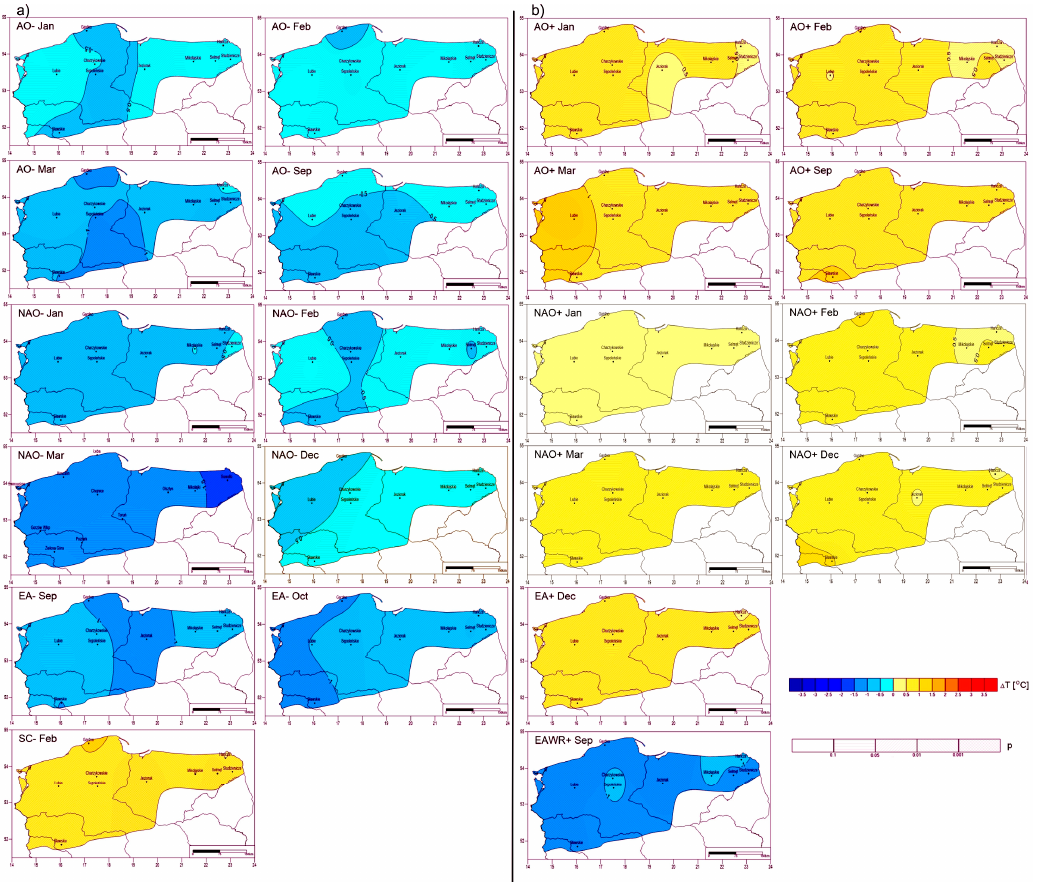
Figure 3. Spatial distribution of differences ( Δ T) in lake water temperature in comparison to mean values in different phases of macroscale types of atmospheric circulation and significance ( p ); ( a ) negative phase; and ( b ) positive